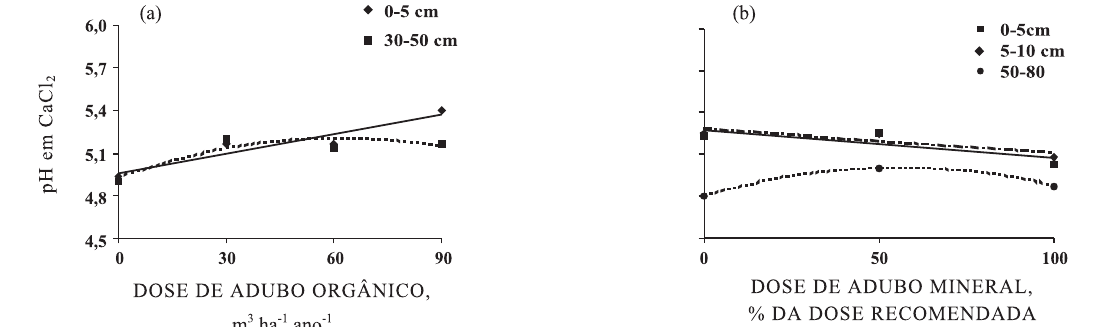
Figura 1. Valores de pH CaCl em Latossolo Bruno sob plantio direto submetido a diferentes doses de esterco 2 líquido de gado leite e adubação mineral, por um período de seis anos, com remoção total da planta: (a) adubação orgânica; (b) adubação